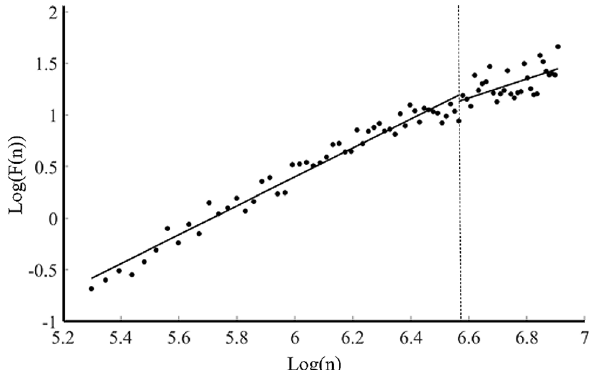
Figure 1. A typical log–log diffusion diagram generated by DFA of the COP data. Schematic representation of the typical log–log diffusion plots resulting from DFA of the COP data. The cross-over phenomenon was detected with slope < 1 or slope > 1. Data of this image were processed using Matlab (R2017a, https ://www. mathw orks.com/produ cts/new_produ cts/relea se201